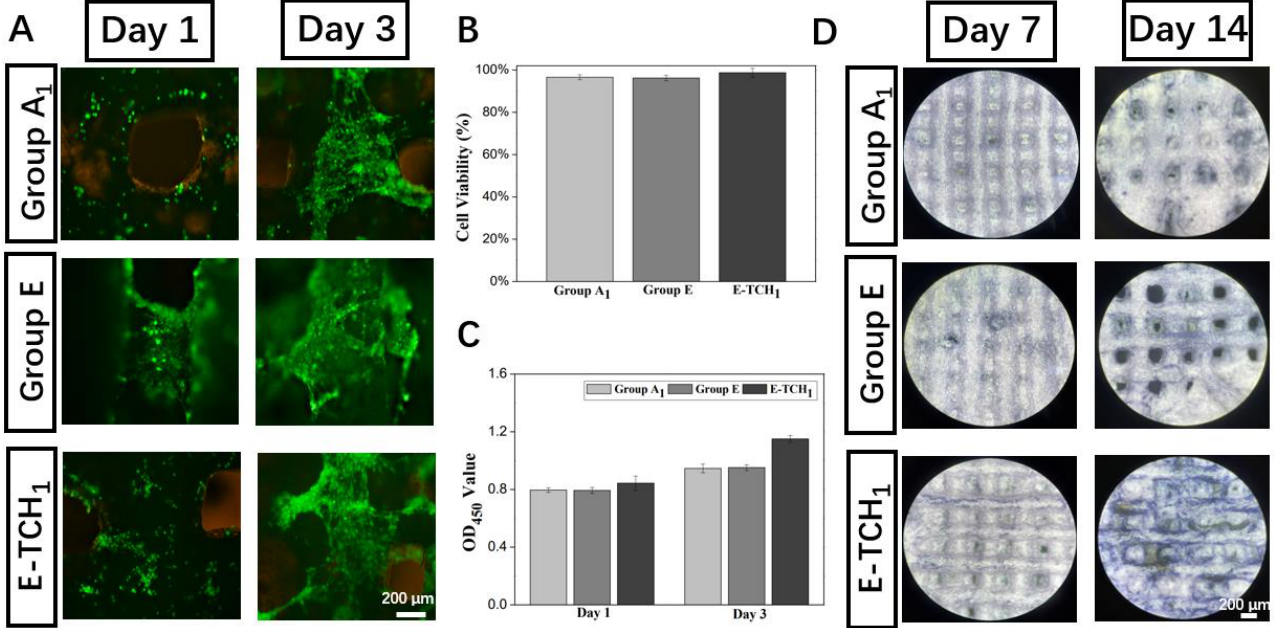
Figure 8. Biological performance of scaffolds: ( A ) live and dead staining images at day 1 and day 3, ( B ) cell viability after 1 day of culture, ( C ) cell proliferation on scaffolds in 3 days, and ( D ) ALP staining of rBSMCs on different scaffolds after 7- and 14 days of culture.